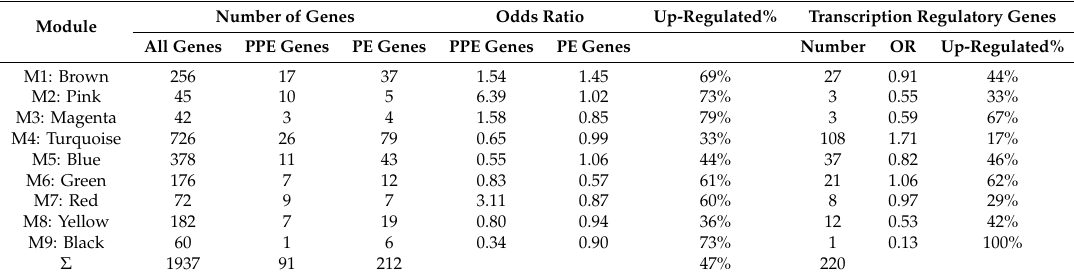
Table 1. Summary of the gene modules in villous trophoblast di ff